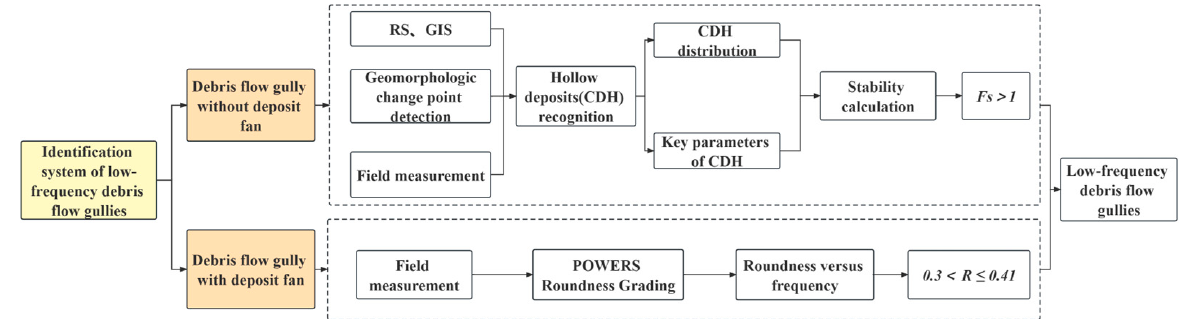
Table 4. Debris flow frequency identification based on roundness.